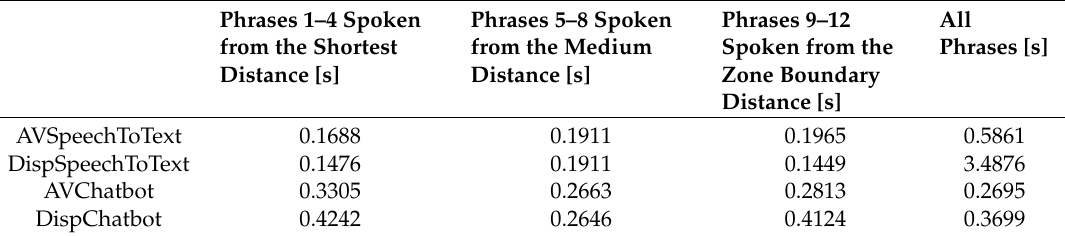
Table 1. Values of average times and dispersion of response time of the Speech-to-text service and